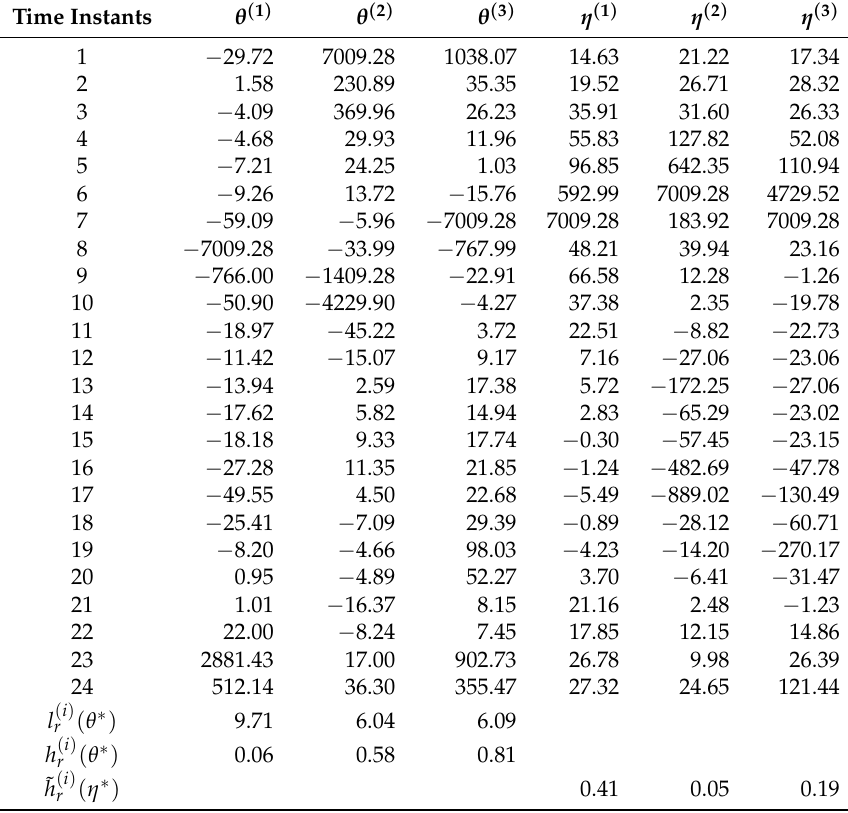
Table 1. Lagrange multipliers θ , η